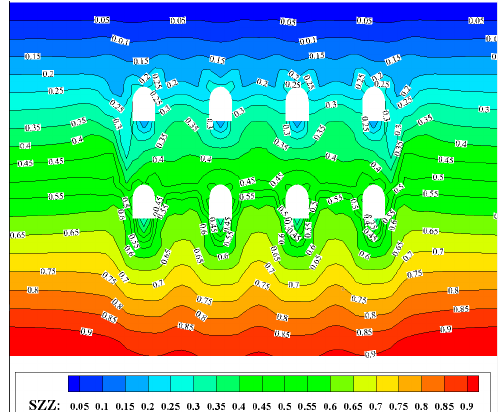
Figure 11. Vertical stress contour (section x = 10 m).